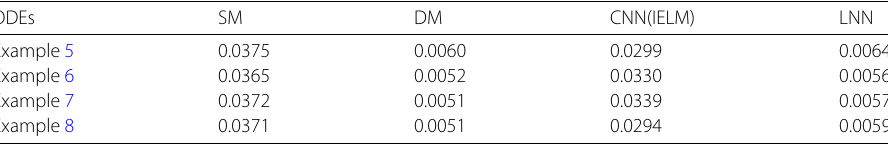
Table 8 Mean absolute deviation of different methods for SODE ODEs EM R-K4 LNN Example 9 y 1